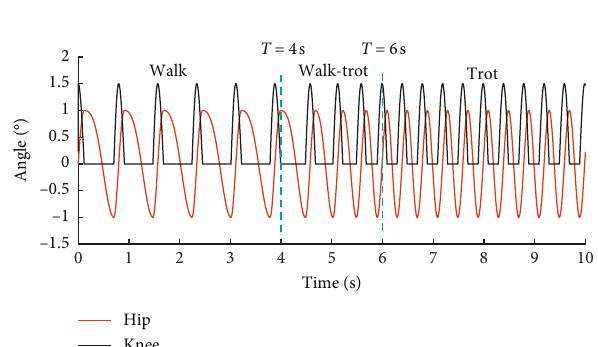
Figure 17: The relationship between hip and knee rotation